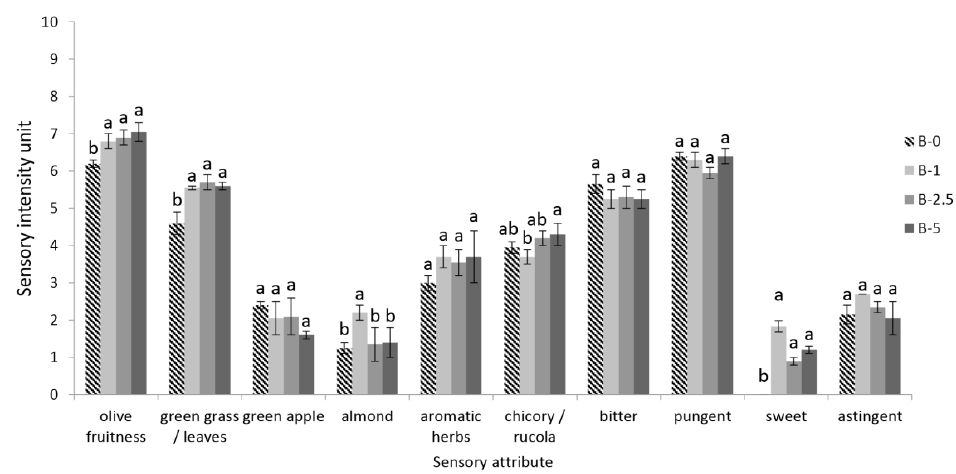
Figure 5. Results of descriptive sensory analysis of Buža olive cultivar oils obtained without (B-0) and with the addition of olive leaf in different amounts: 1% (B-1), 2.5% (B-2.5) and 5% (B-5). Results represent the mean values of medians of three technical repetitions ± standard deviations. Different letters above bars represent significant differences among the treatments (Tukey ´ s test, p < 0.05) for each sensory attribute separately.